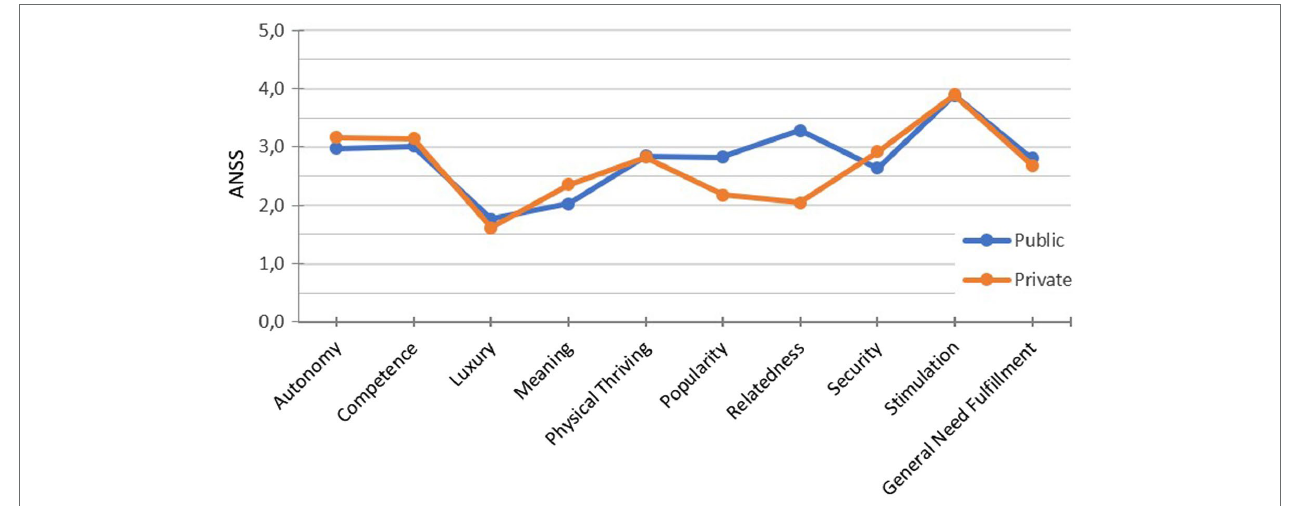
FIGURE 3 | Needs profiles for recalled experiences in public and private context. ANS, average need fulfillment